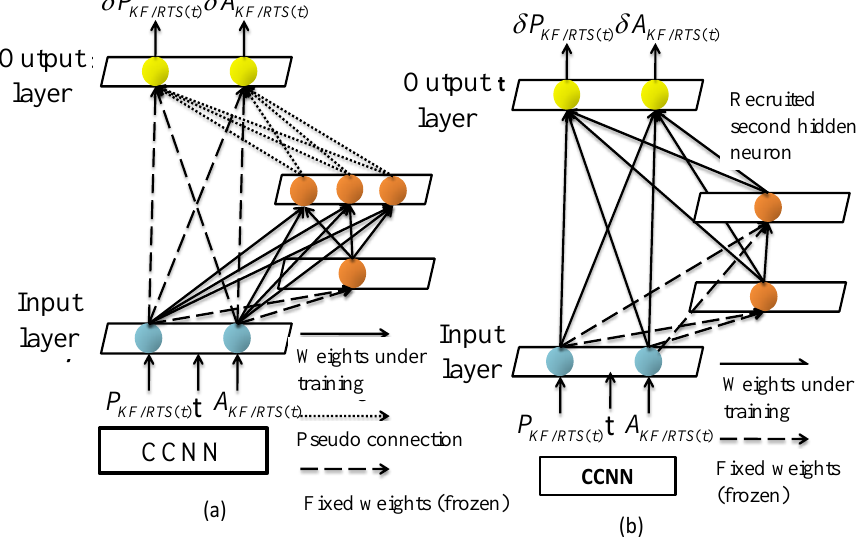
Figure 12 . The recruitment and installation of the second hidden neuron.